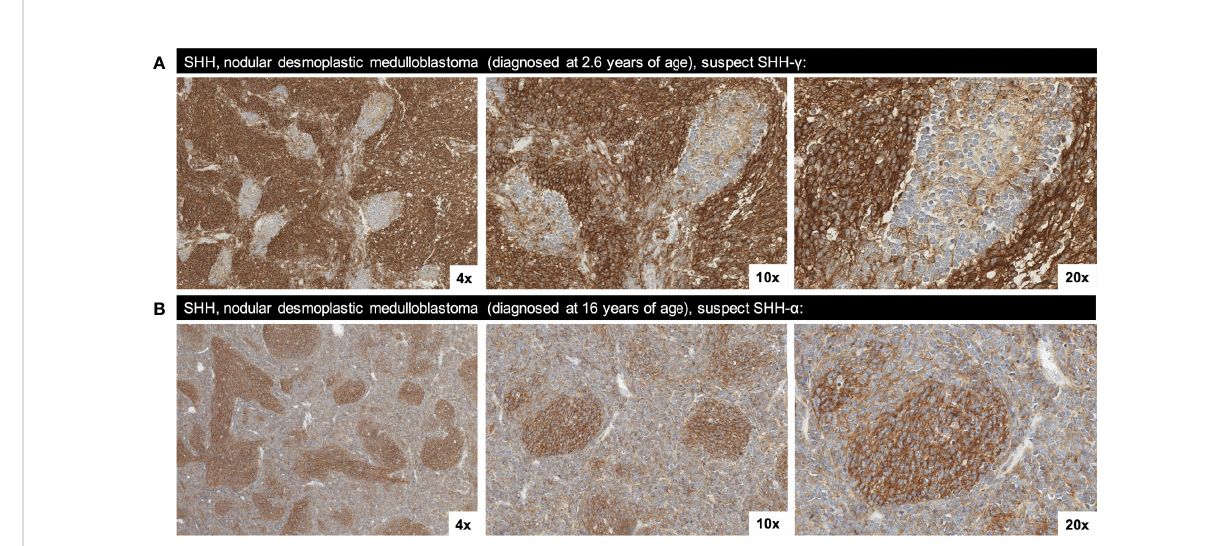
FIGURE 4 Two morphological patterns of SST2A staining observed in SHH, nodular/desmoplastic medulloblastoma. (A) SST2A IHC of SHH medulloblastoma (in a patient diagnosed at 2.6 years of age) demonstrating an inverse correlation between membranous SST2A expression and tumor cell maturation; the more immature cells exhibit strong, complete, circumferential SST2A IHC positivity, whereas the more mature cells comprising the nodules lack membranous expression (yet have cytoplasmic granularity). (B) SST2A IHC of SHH medulloblastoma (in a patient diagnosed at 16 years of age), with more primitive cells lacking membranous SST2A expression while the nodules ’ differentiating cells exhibit SST2A positivity (though not consistently membranous). Images in both cases are shown at 4x, 10x, and 20x magni fi